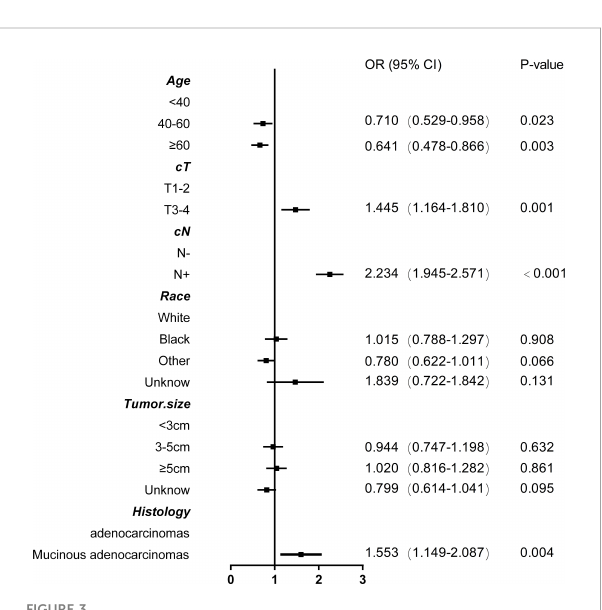
FIGURE 3 Forest plot with odds ratios base on multivariable logistic model associations with lymph node metastasis in rectal cancer patients after neoadjuvant chemoradiotherapy.